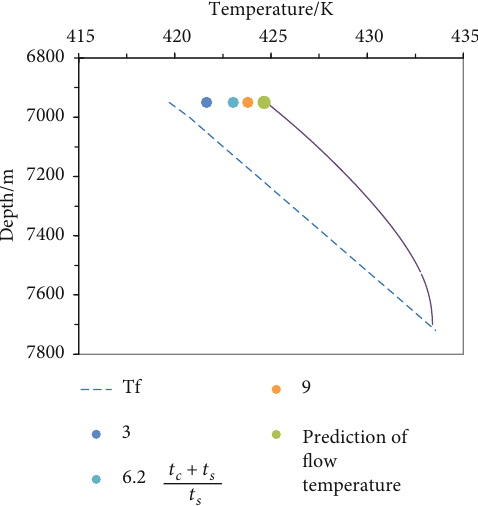
Figure 12: Temperature log and prediction temperature of well